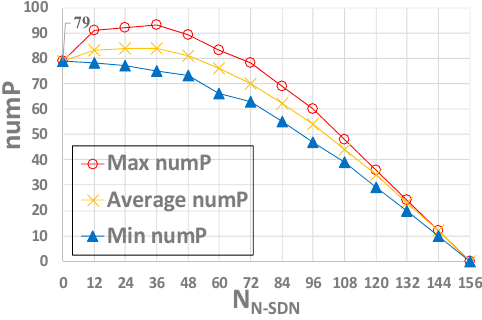
Figure 7. The influence of the number of N ‐ SDN nodes on numP.